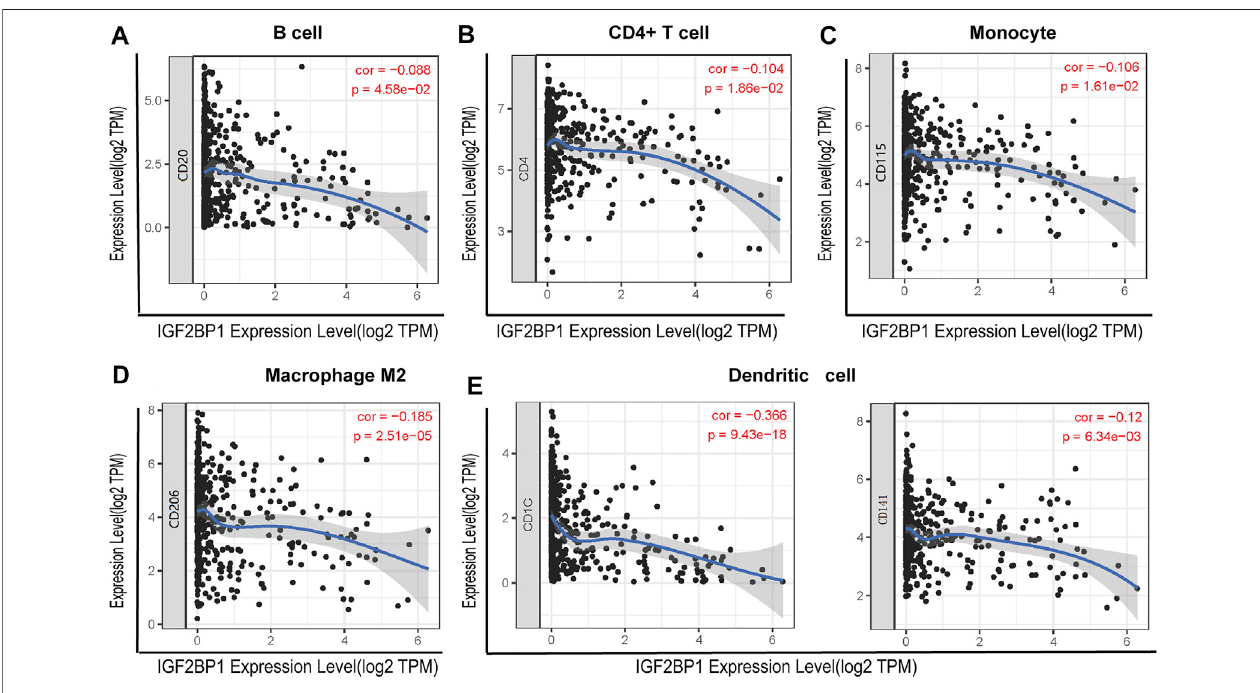
FIGURE7| Correlationbetween IGF2BP1 expressionandtheexpressionofmarkergenesofin fi ltratingimmunecellsinLUADusingtheTIMERdatabase. (A) Bcell (CD20); (B) CD4 + Tcell(CD4); (C) monocytes(CD115); (D) macrophageM2(CD206);and (E) dendriticcell(CD1CandCD141). IGF2BP1 wasrepresentedonthe x -axis with gene symbols, and related marker genes are represented on the y -axis as gene symbols. The gene expression level was displayed with log2